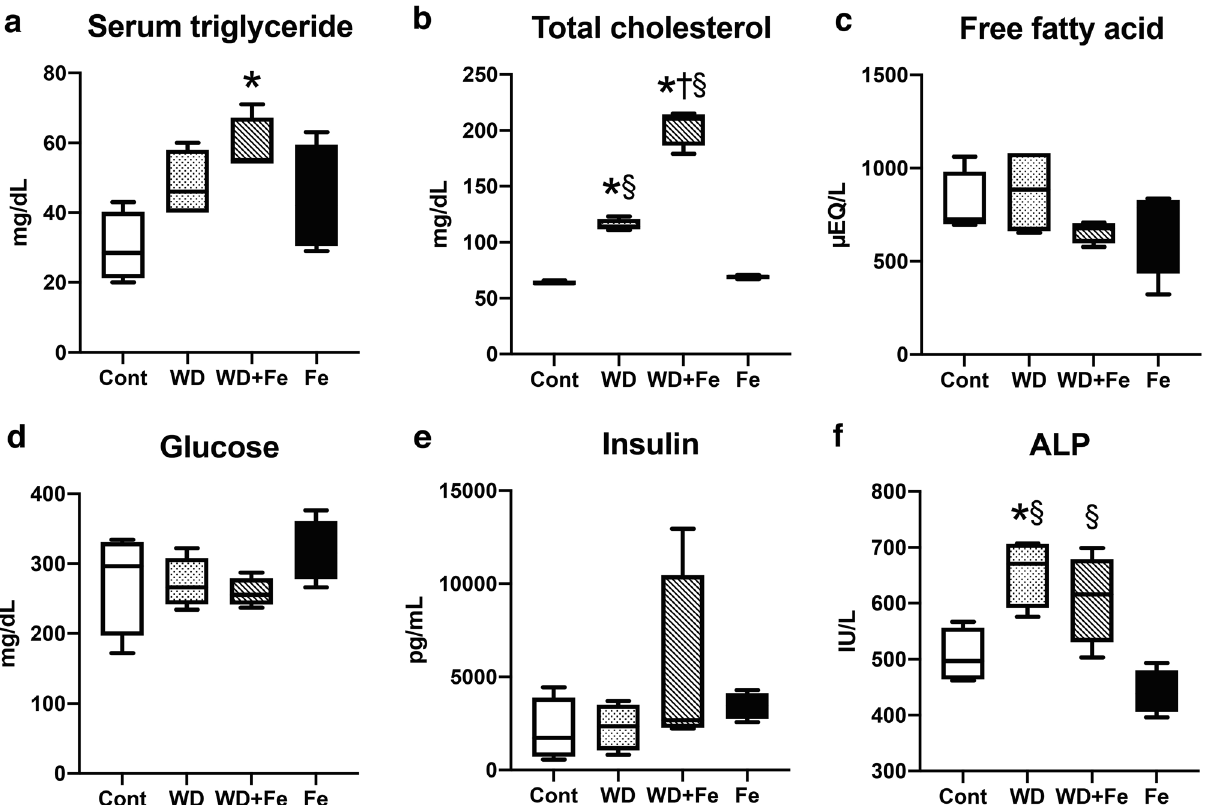
Figure 4. Blood biochemical data of ( a ) serum triglyceride, ( b ) total cholesterol, ( c ) free fatty acid, ( d ) glucose, ( e ) insulin, and ( f ) alkaline phosphatase (ALP) at weeks 26. Data are presented as box and whiskers (n = 4/ group). * P < 0.05 versus Cont, † P < 0.05 versus WD, and § P < 0.05 versus Fe by one-way ANOVA followed by Tukey’s multiple